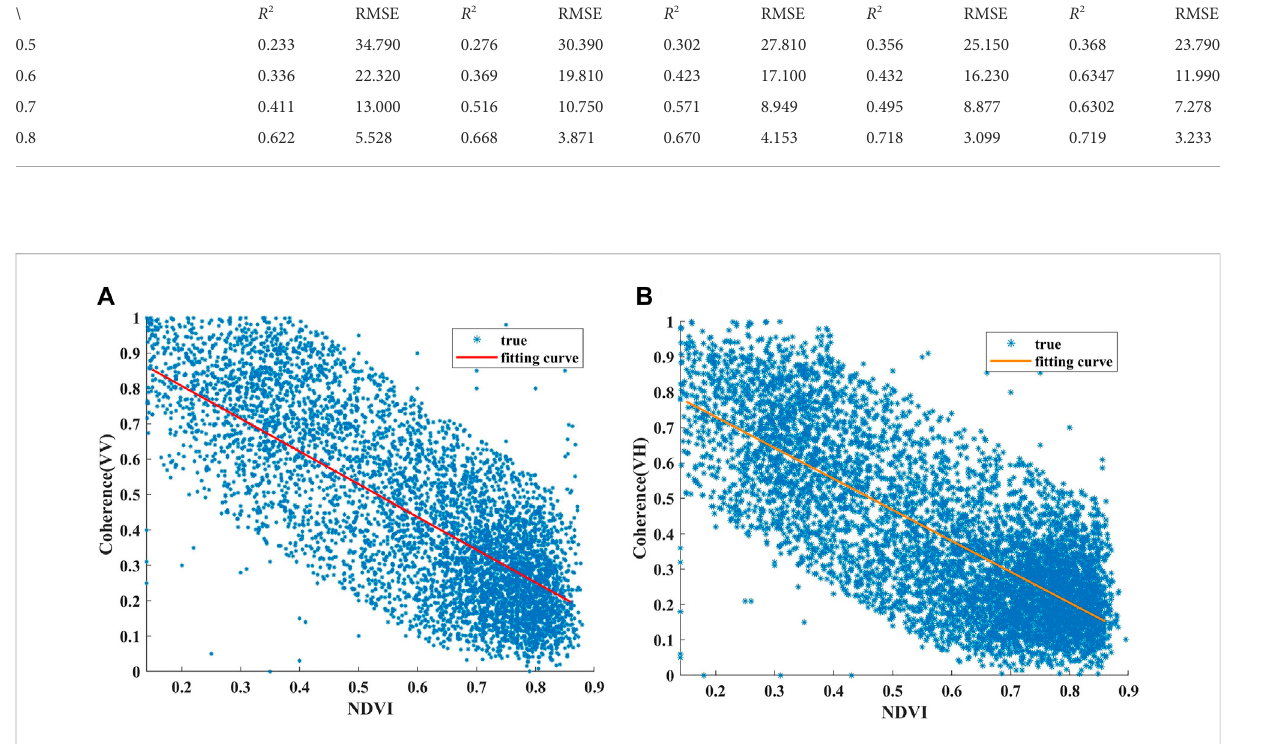
image (Figure 10B) of the validation area. Those in VH- polarization are displayed in Figures 10C, D, respectively. Figures 10E, F give the differences distribution in validation area were obtained by subtracting the estimated coherence from